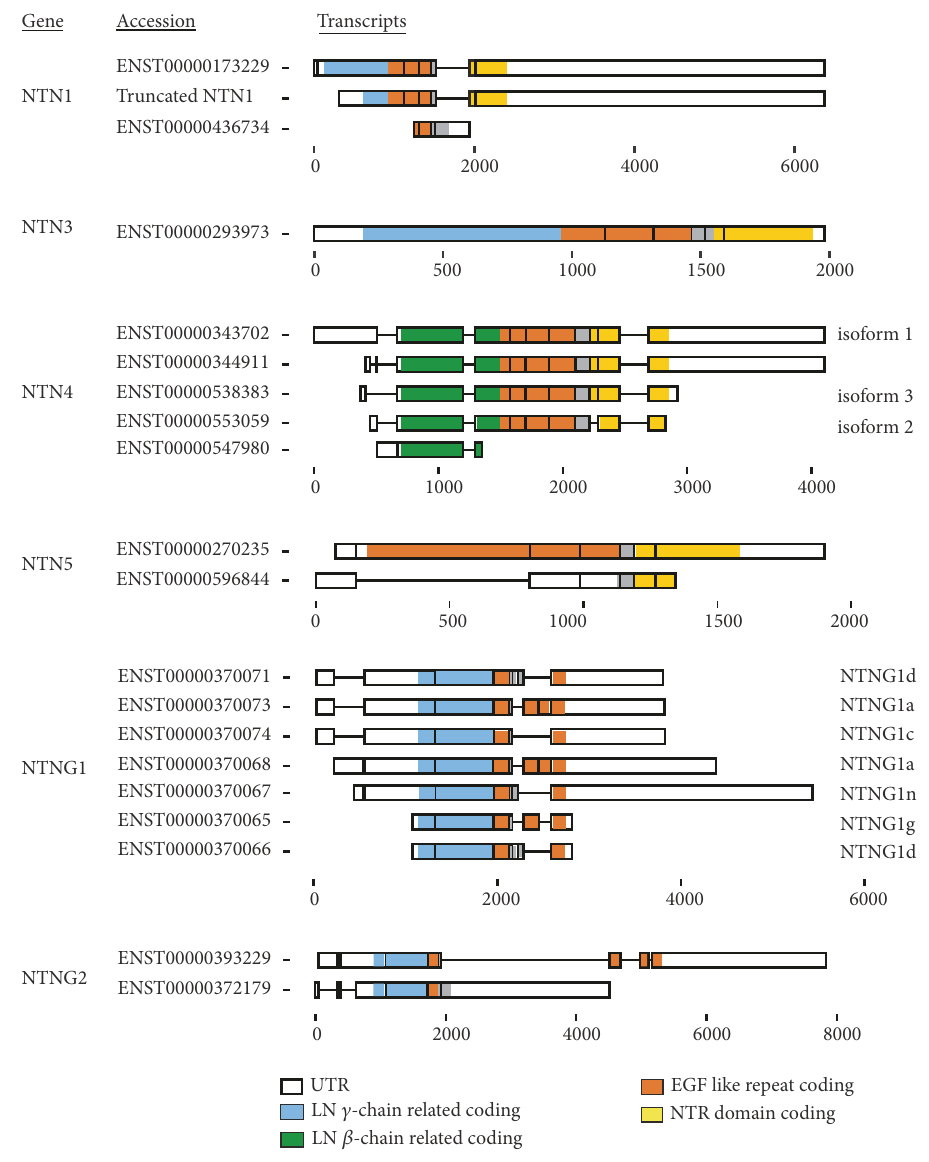
Figure2:Schematicexoniccompositionofthealternativesplicednetrinisoformswithevidenceofproteintranslation.Accessionnumbersare Ensembl annotations. Colors indicate coding regions of the different protein domains. White boxes indicate untranslated regions. Numbers are of base pare